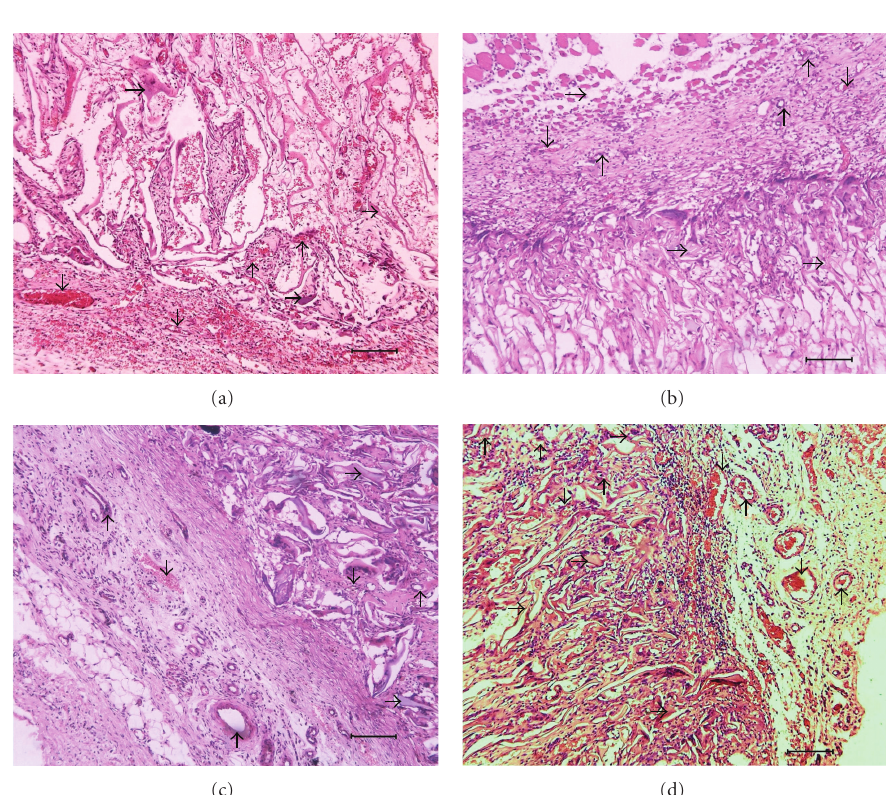
Figure 2: Tissue slices of PSFFs at di ff erent time ( × 100). (a, b, c, and d are the images at 5d, 10d, 18d, and 23d after implantation; ↓ : venules ↑ : arteriole; → : porous silk fibroin film; bar: 100 µ